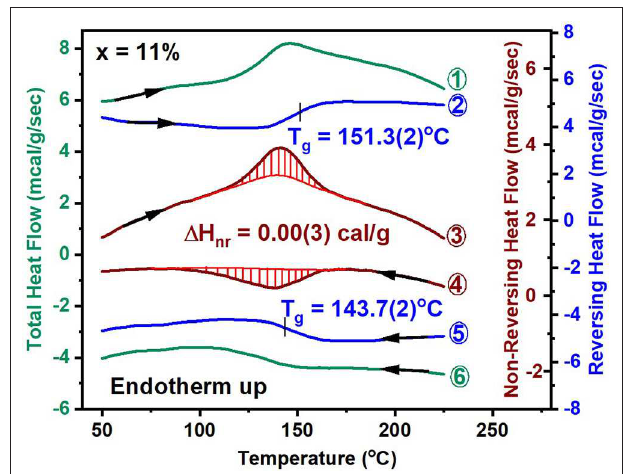
FIGURE 3 | MDSC scan of a Ge x As x Se 100 − 2x glass at x = 11%, showing the total, reversing and non-reversing heat flow as curves labeled 1, 2, and 3 in the heating cycle. The corresponding heat flow terms in the cooling cycle are labeled as curves 4, 5, and 6. See text for the operating parameters. The mean value of T g of 151.3 ◦ C in the heating cycle and of 143.7 ◦ C in the cooling cycle yields the scanning rate independent T g . The frequency corrected enthalpy of relaxation, 1 H nr (x) is obtained by subtracting the exothermic contribution shaded in red (curve 4) from the endothermic one (in curve 3). The typical operating conditions are as follows; linear T ramp at 3 ◦ C/min, modulation time of 100s, and modulation amplitude at ± 1 ◦